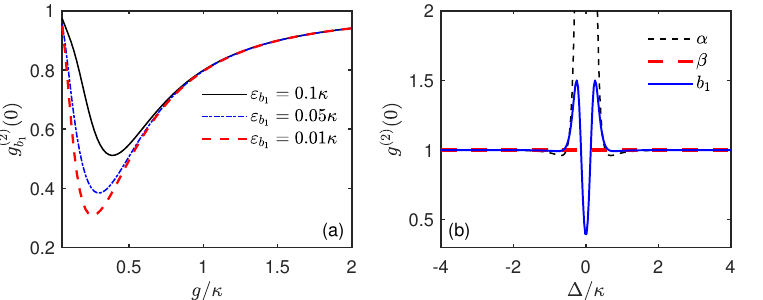
( 2 ) ( 0 ) of the SAW mode b 1 b 1 / κ in the mechanical resonant 1